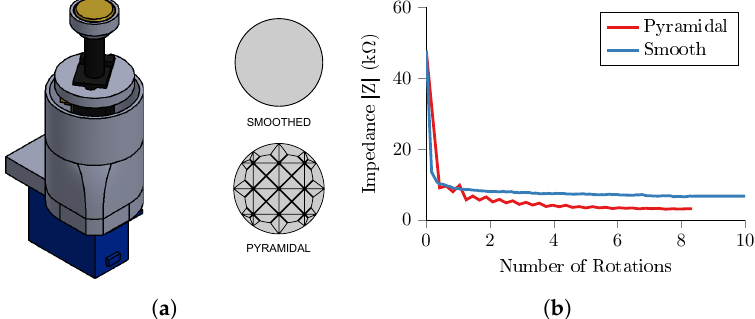
Figure 11. Single Unit Abrasion Experiments ( a ) unit with pyramidal abrasive pattern on smooth ( b ) abrasion in orange skin test rig for both patterns using abrasive